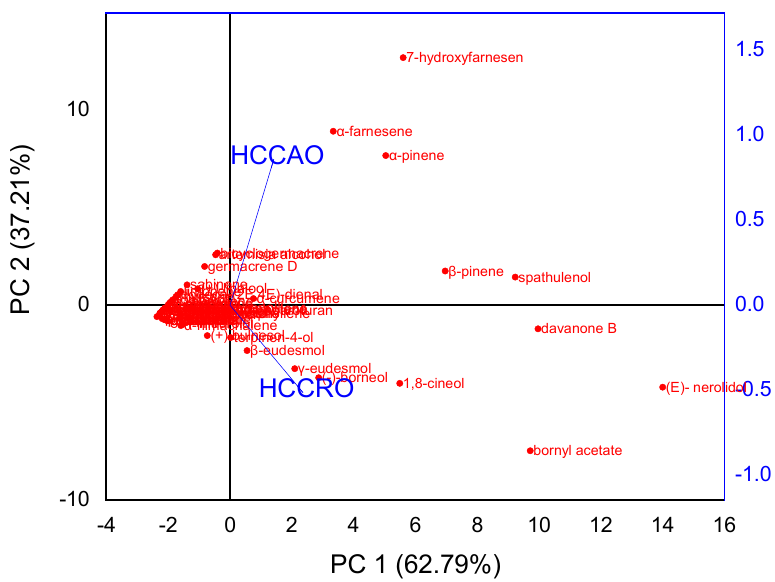
Figure 3. Principal Component Analysis (PCA) of HCCAO and HCCRO.